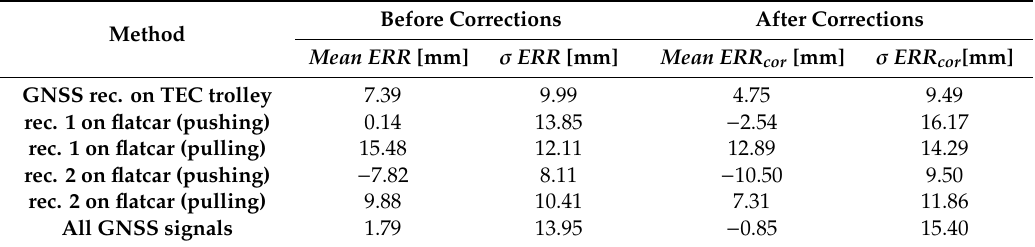
Figure 17. Signal of the ERR value along the length of a fragment of a railway line in a circular curve with a radius of 𝑅 = 1000 m. ( a ) Signal before correction of the arc versines, ( b ) Signal after correction.